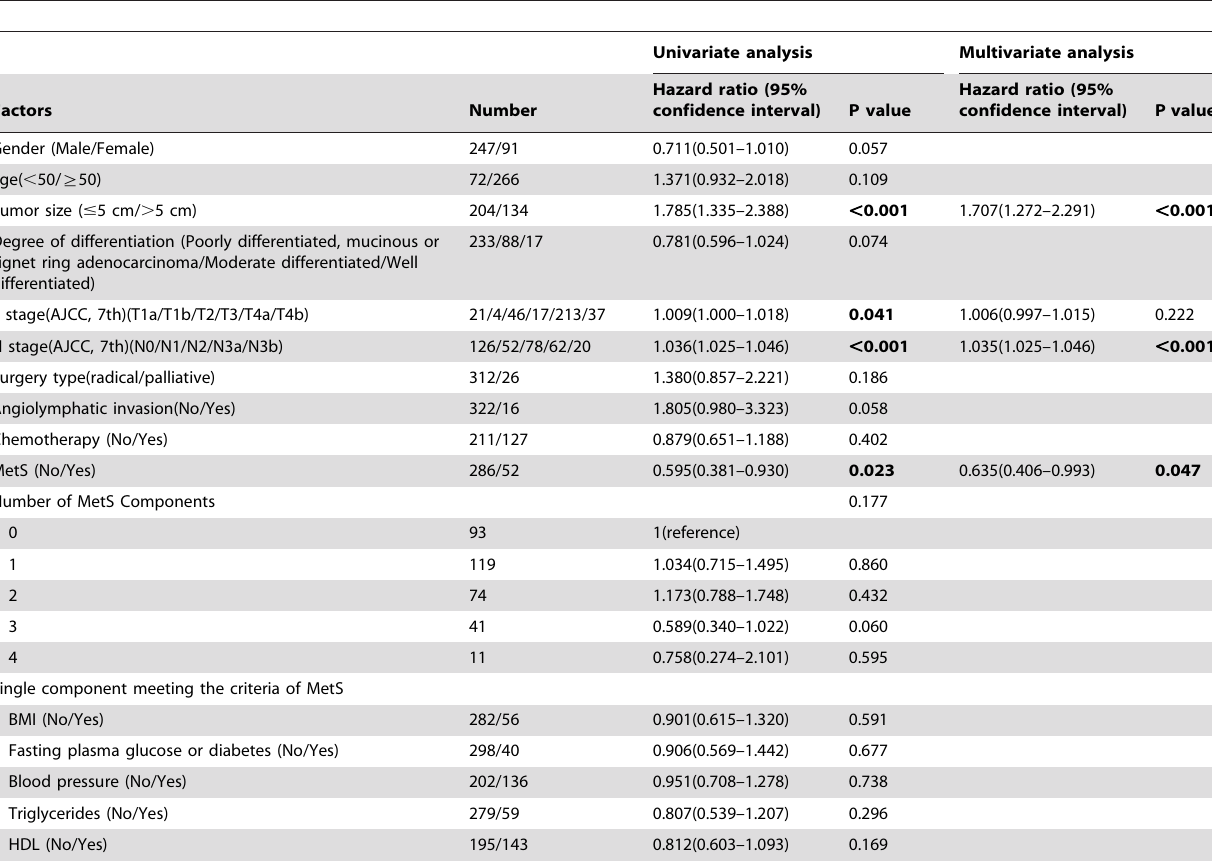
Table 3. Association between metabolic syndrome (MetS) and overall survival in patients with proximal tumor in a univariate and multivariate